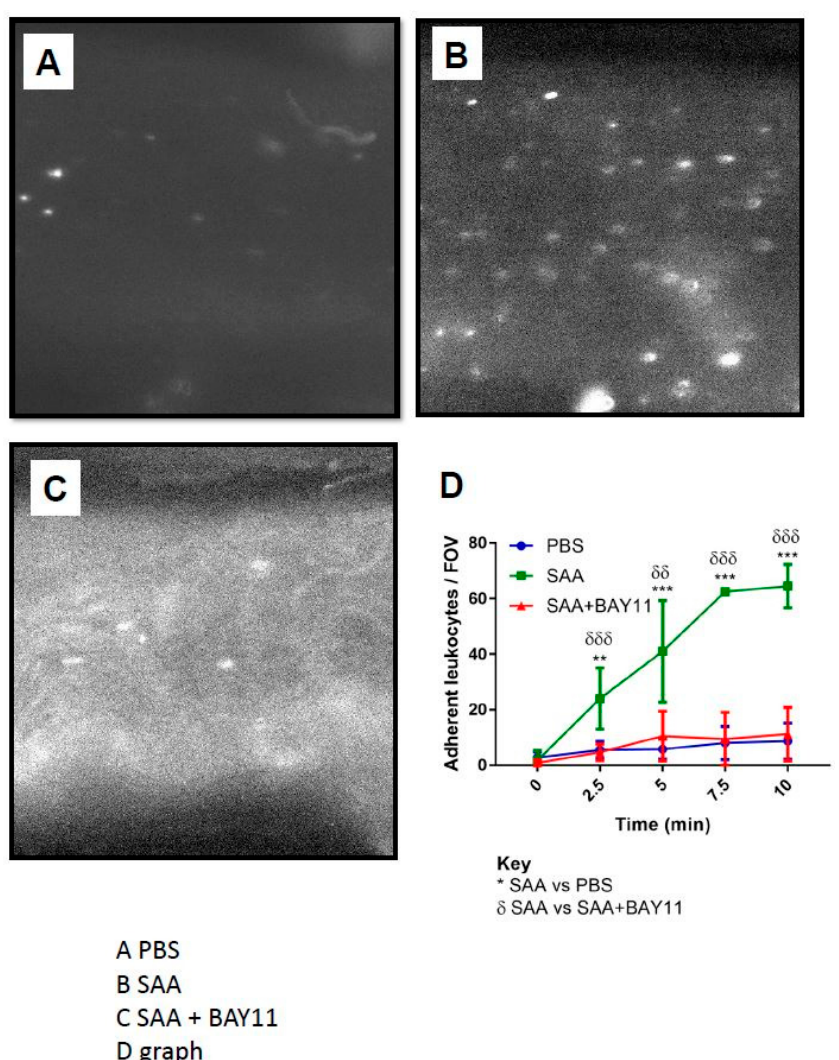
Figure 5. BAY11-7082 reduces ex vivo leukocyte adhesion induced by SAA in mice aorta. Mice were administered BAY11-7082 (5 mg/kg) or PBS (control) over a 14day period in parallel with administration of SAA (120 µ g/kg; PBS as control) as described in the Methods Section. Aorta were subsequently isolated and subjected to ex vivo leukocyte adhesion studies using total labelled leukocytes. Arrows indicate leukocytes adhered to the aortic surface of mice treated with ( A ) SAA alone and ( B ) SAA + BAY11-7082. ( C ) Adherent leukocytes were quantified per field of view (FOV) by counting the number of dye-stained leukocytes that ceased motion during a 30 s recording at various time intervals under 160x magnification. Data represent mean ± SD. Independent aortic samples n = 4 SAA (time = 0; 2.5 min); n = 3 SAA (time = 5 min); n = 2 SAA (time = 7.5; 10 min); n = 6 SAA + BAY11-7082 (time = 0; 2.5; 5 min); n = 5 SAA + BAY11-7082 (time = 0 = 7.5; 10 min). * Different to SAA-only group ** p < 0.05 and *** p < 0.001. Data represent 3 technical and 3 biological replicates.